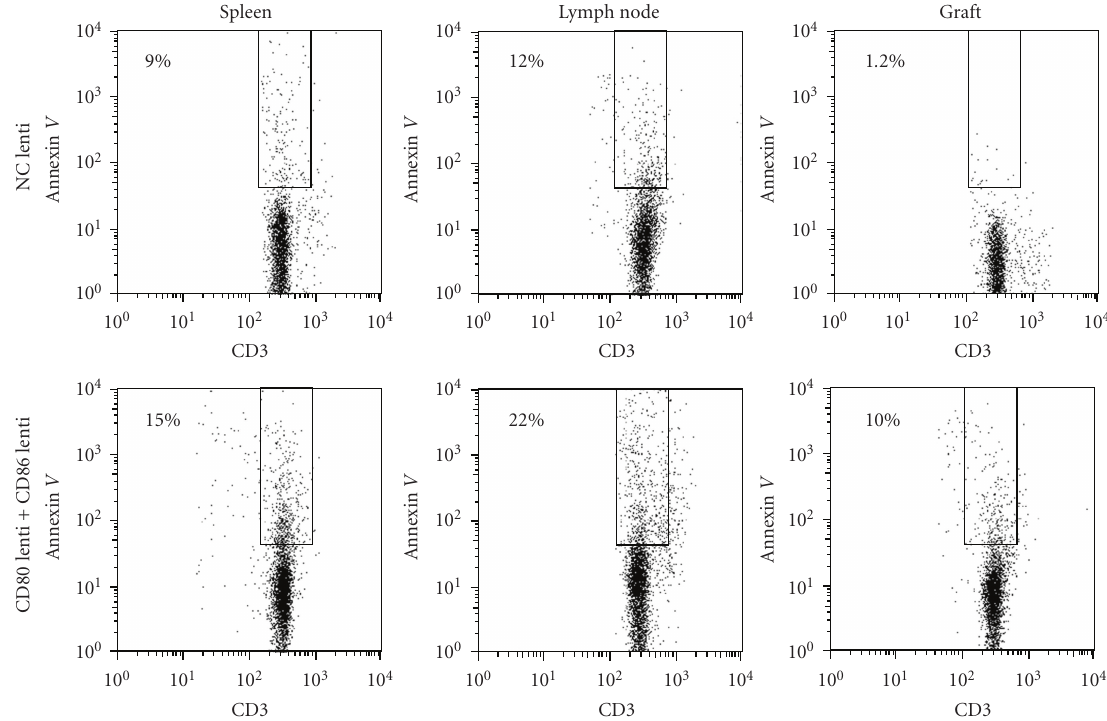
Figure 6: Lymphocytes were isolated from recipient spleens, mesenteric lymph nodes, and grafts on day 5 after transplantation treated with recombinant lentivirus transduced DCs; these cells were double stained with FITC-conjugated anti-CD3 and PE-conjugated Annexin V, analyzed by flow cytometry. Numbers indicate the percentage of Annexin V positive cells in CD3+ cell